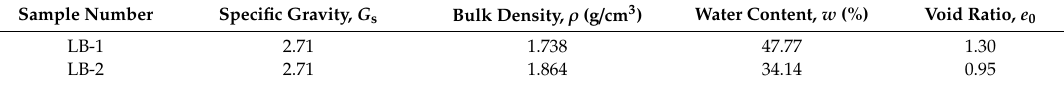
Table 3. Basic properties of the rheological consolidation test sample.